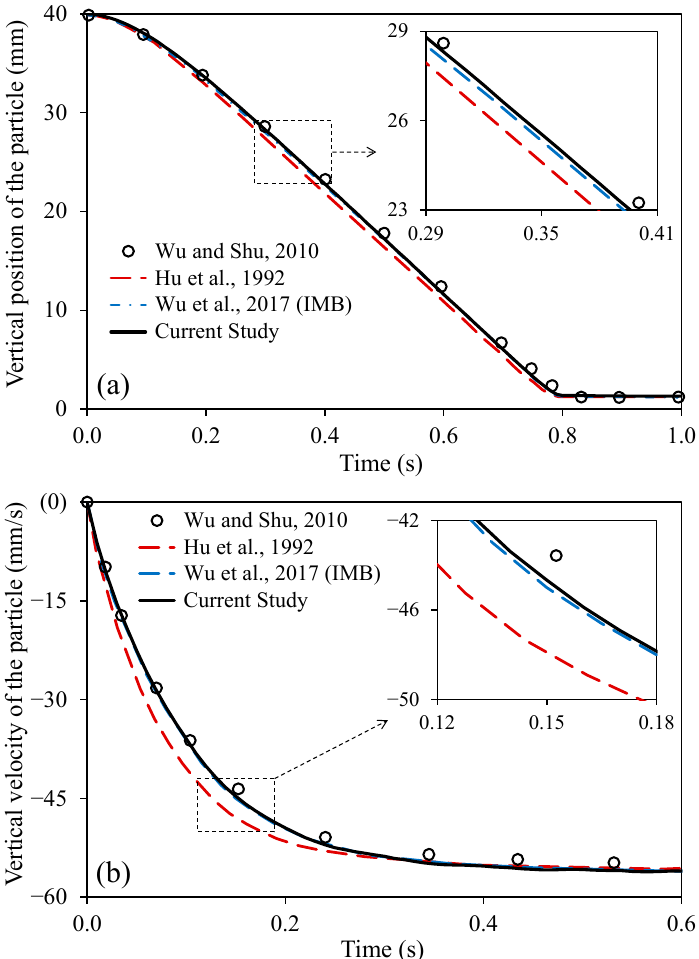
Figure 6. Variation of: ( a ) Vertical position and ( b ) vertical velocity of the settling particle with time.